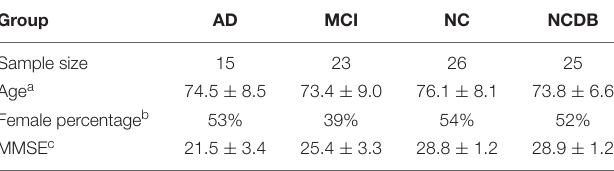
TABLE 1 | Descriptive baseline statistical information for the